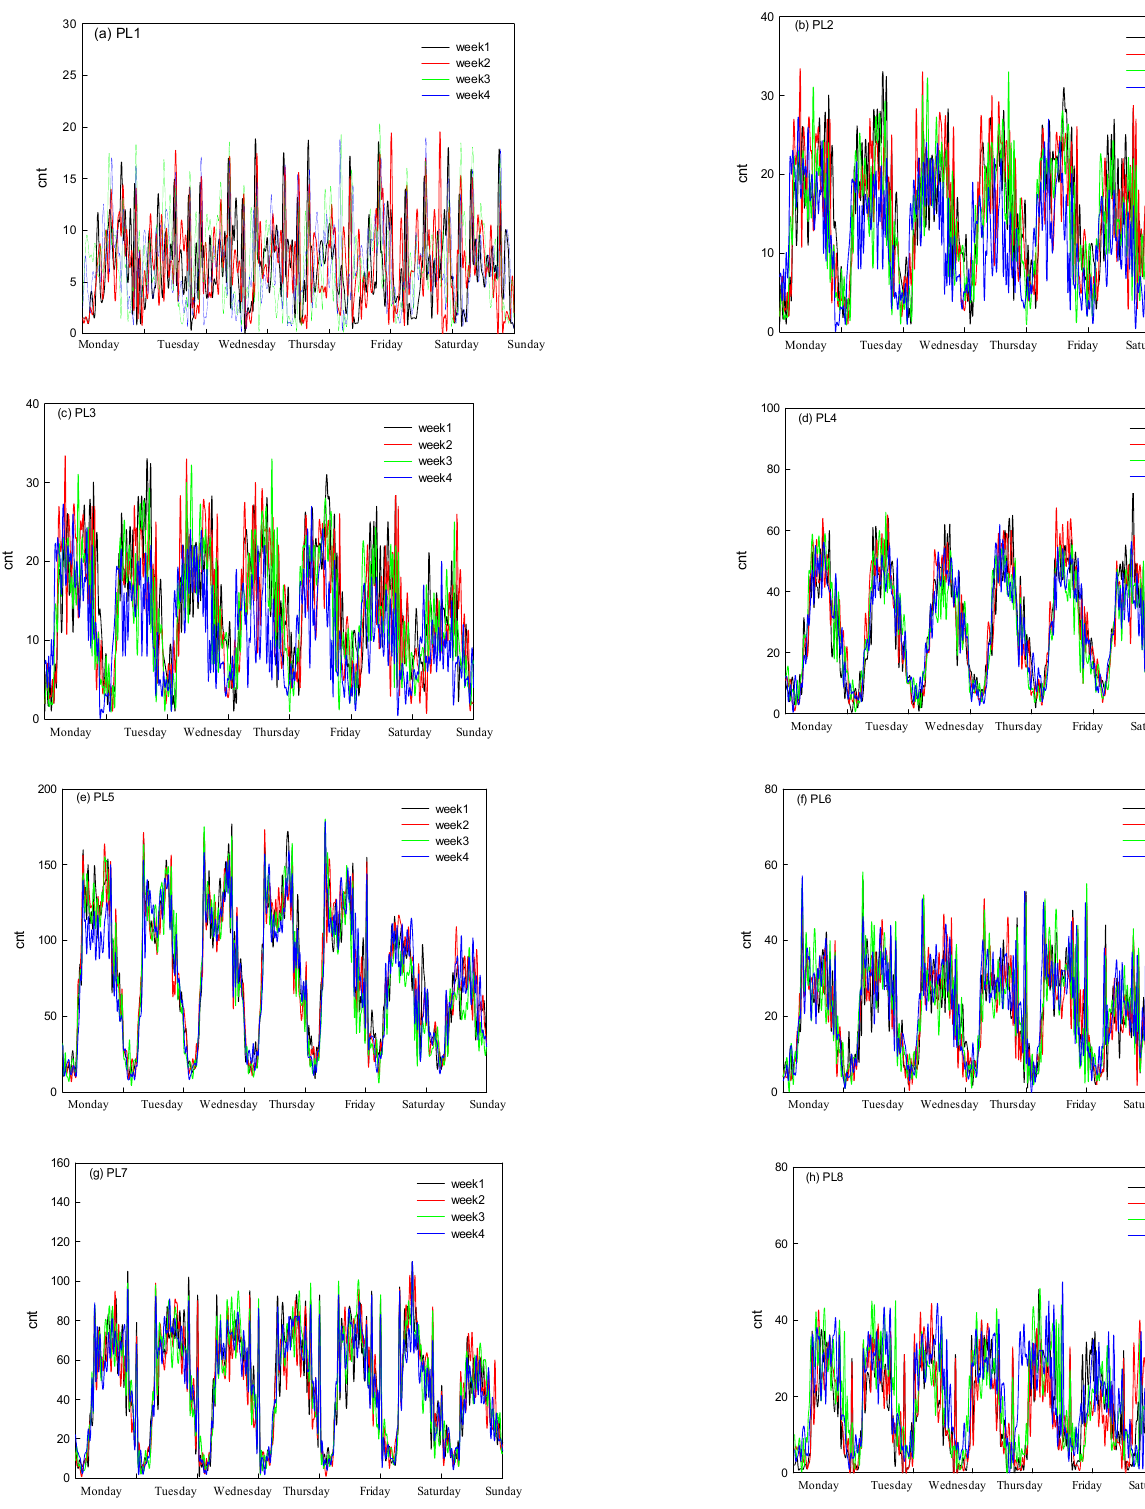
Figure 9. Relation between parking occupancy rate and time for four week 4.2. Comparison between Prediction Results and Actual Data for Four Models